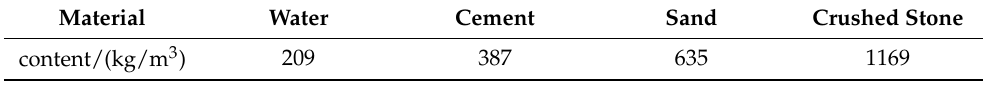
Table 2. Concrete mix